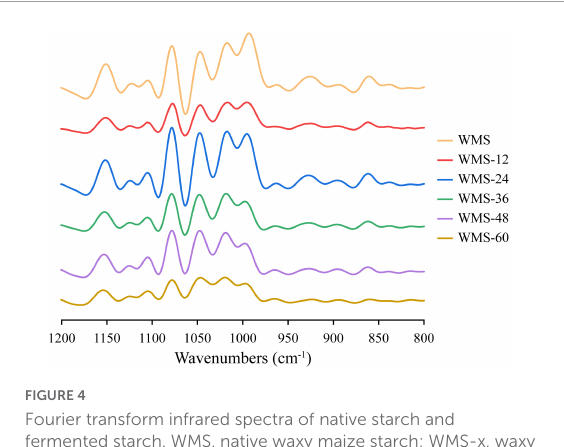
FIGURE2 The particle size distribution of native starch and fermented starch. WMS, native waxy maize starch; WMS-x, waxy maize starch fermented for x h.